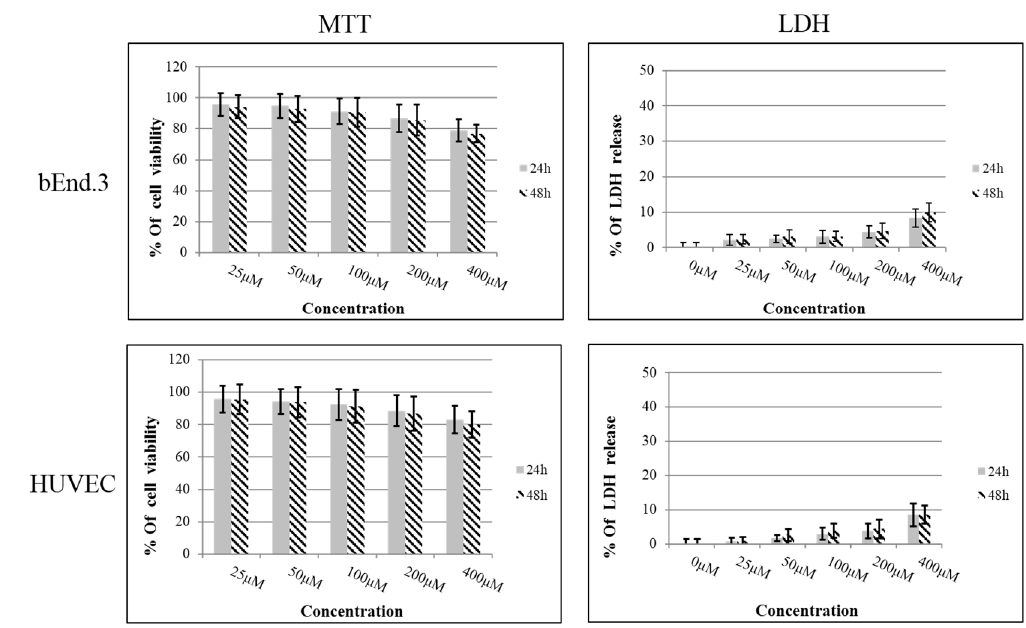
Figure 4. MTT and LDH results after 24 and 48 h of treatment of bEnd.3 and HUVEC AEP-K-FP. Data expressed as mean ± SD of n = 6.